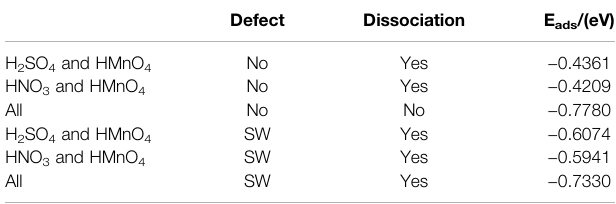
TABLE 3 | Reaction of mixed components on the surface of graphene without